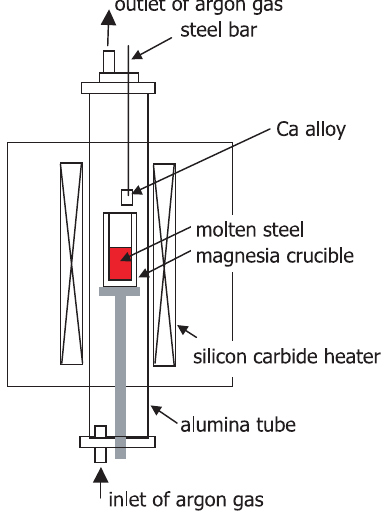
Fig. 1: The laboratory-scale experiment set